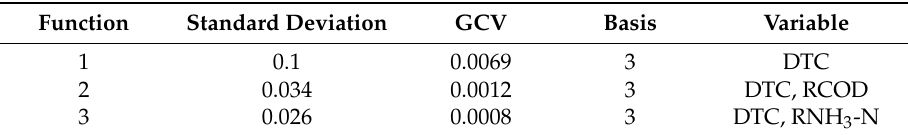
Table 5. Results of ANOVA decomposition for total